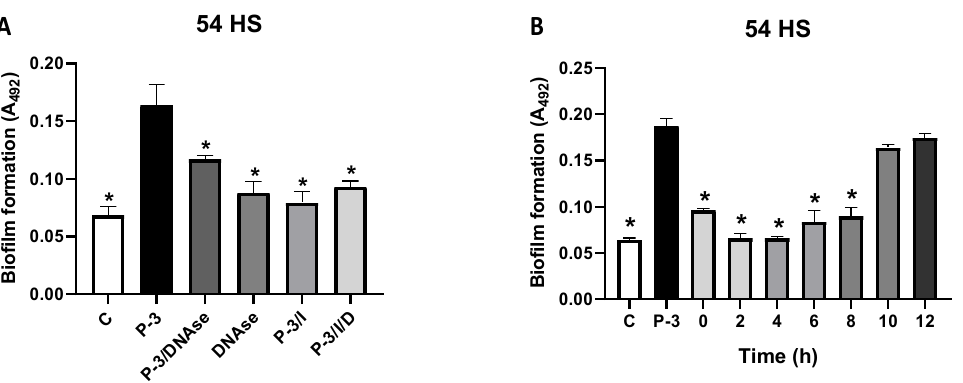
Figure 9. Effect of DNAse in proteinase-3-induced biofilm. ( A ) Bacteria without treatment with proteinase-3, C; bacteria treated with proteinase-3 at 25 ng/mL (P-3); bacteria treated with proteinase- 3 and with 2 U DNAse I (P-3/DNAse); bacteria treated with 2 U DNAse I (DNAse); bacteria treated with proteinase-3 and with 5 mM PMSF inhibitor (P-3/I); bacteria treated with proteinase-3, and 5 mM PMSF inhibitor and 2 U DNAse I (P-3/I//D). ( B ) Bacteria without treatment with proteinase-3, C; bacteria treated with proteinase-3 at 25 ng/mL (P-3); bacteria treated with proteinase-3 more 2 U DNAse I at different times (0, 2, 4, 6, 8, 10, and 12 h). The abundance of biofilm was determined according to Christensen et al. Asterisk * indicates a significant difference ( p < 0.05) to the P-3. The statistical analysis was performed using a one-way ANOVA with Tukey’s